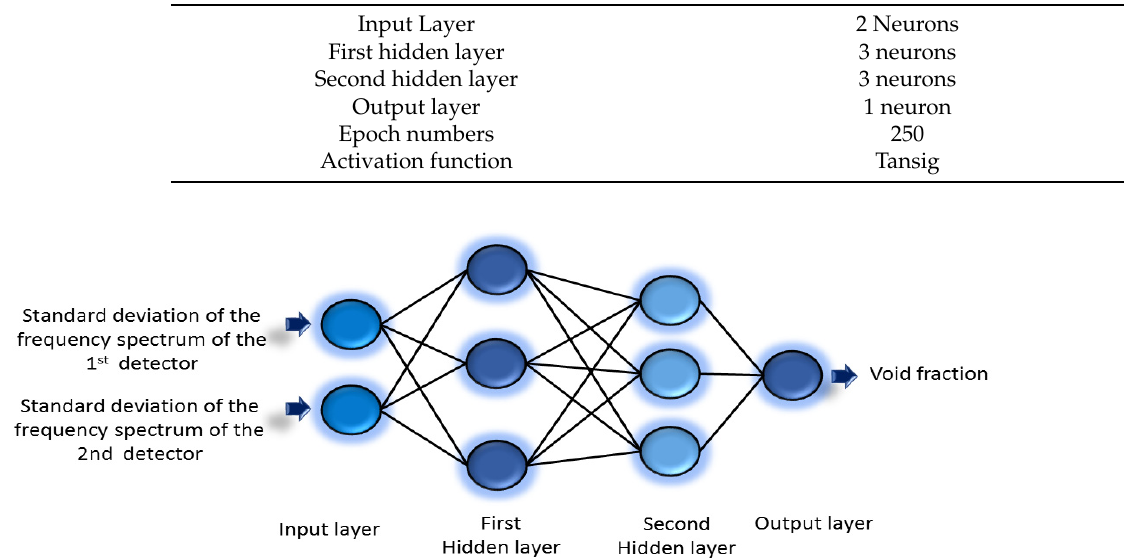
Figure 11. The performance of implemented ANN for regime classification (training and testing data samples).